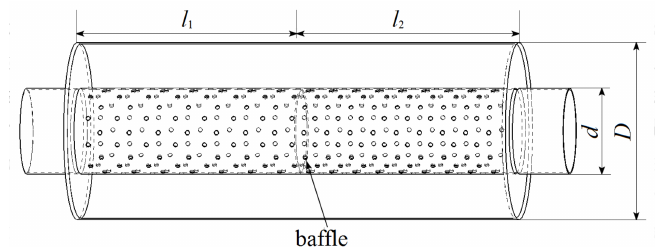
Figure 3. Cross-flow perforated tube silencer.